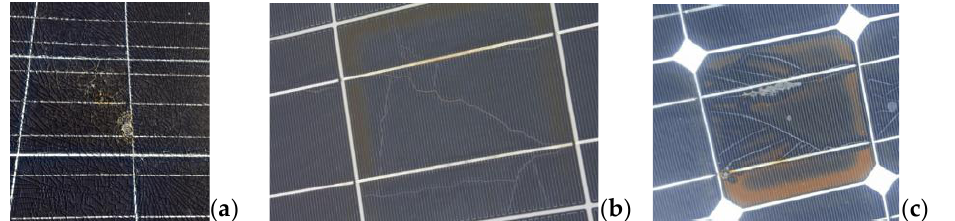
Figure 11. ( a ) Falling debris and breakage for impacts; ( b ) water damage; ( c ) contamination of snail traces.